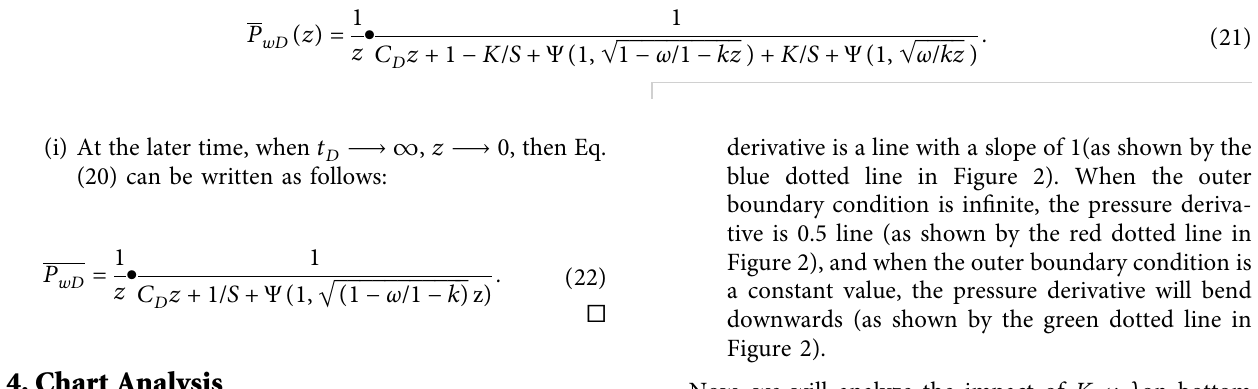
e 2 S � 1, K � 0 . 9 , ω � 10 − 3 , λ � 10 − 5 D